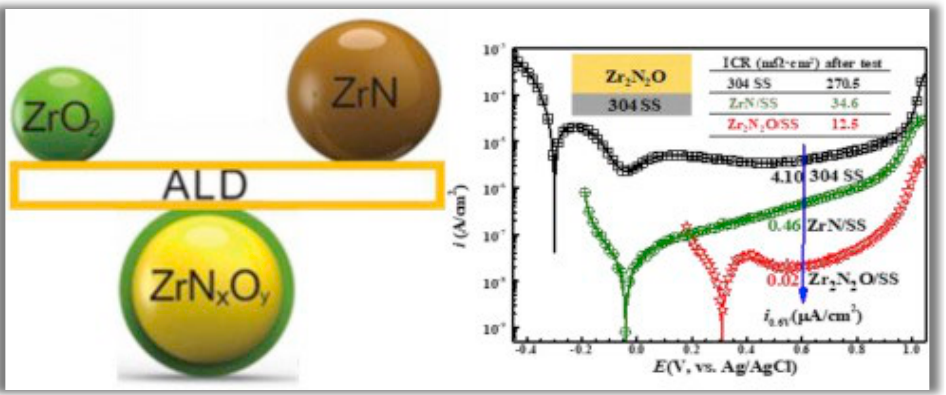
Figure 10. Potentiodynamic polarization curves of 304 stainless steel (SS), ZrN/304 SS, and Zr 2 N 2 O/304 SS. Reprinted with permission from Ref. [93]. Copyright 2018, Elsevier. Sowa et al. [94] and Tian et al. [95] grew thin films of niobium nitride (NbN) that have